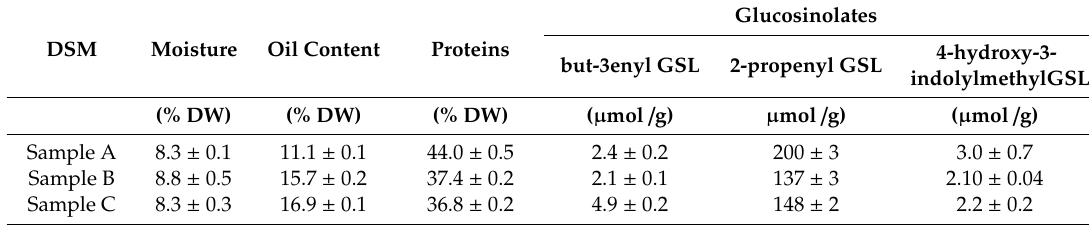
Table 4. B. juncea defatted seed meals (DSMs): main characterization. Mean values ± SD ( n = 3) are shown. The results are expressed as percentage (%) on dry matter basis and µ moles · g − 1 of seed meal (dry